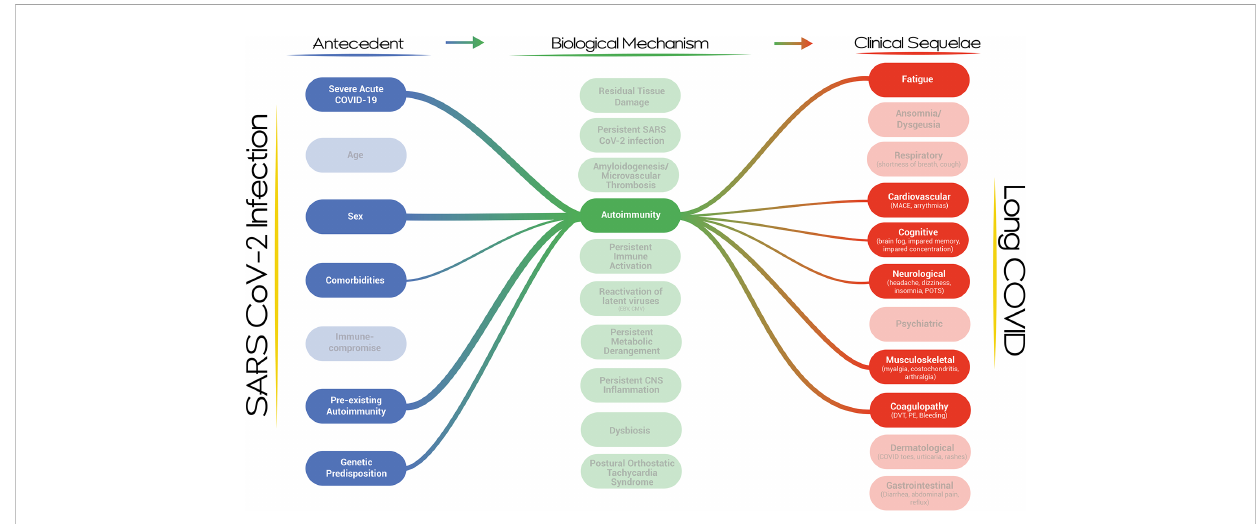
FIGURE 2 A network map of the risk factors and clinical sequelae associated with autoimmunity in the context of Long COVID.